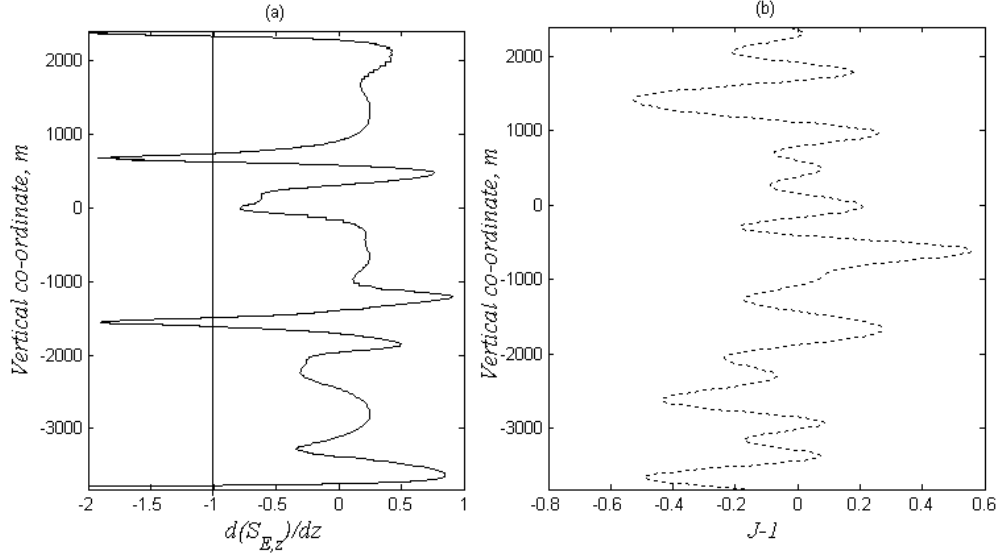
Fig. 4. Vertical profiles of the vertical gradient of the Eulerian displacements, ∂S E,z /∂z , and of the relative volume deformations of fluid parcels, J 1 = J − 1, for the case shown in Fig. 2. (a) ∂S E,z /∂z vs. vertical Eulerian co-ordinate z − c r . Vertical straight line corresponds to the